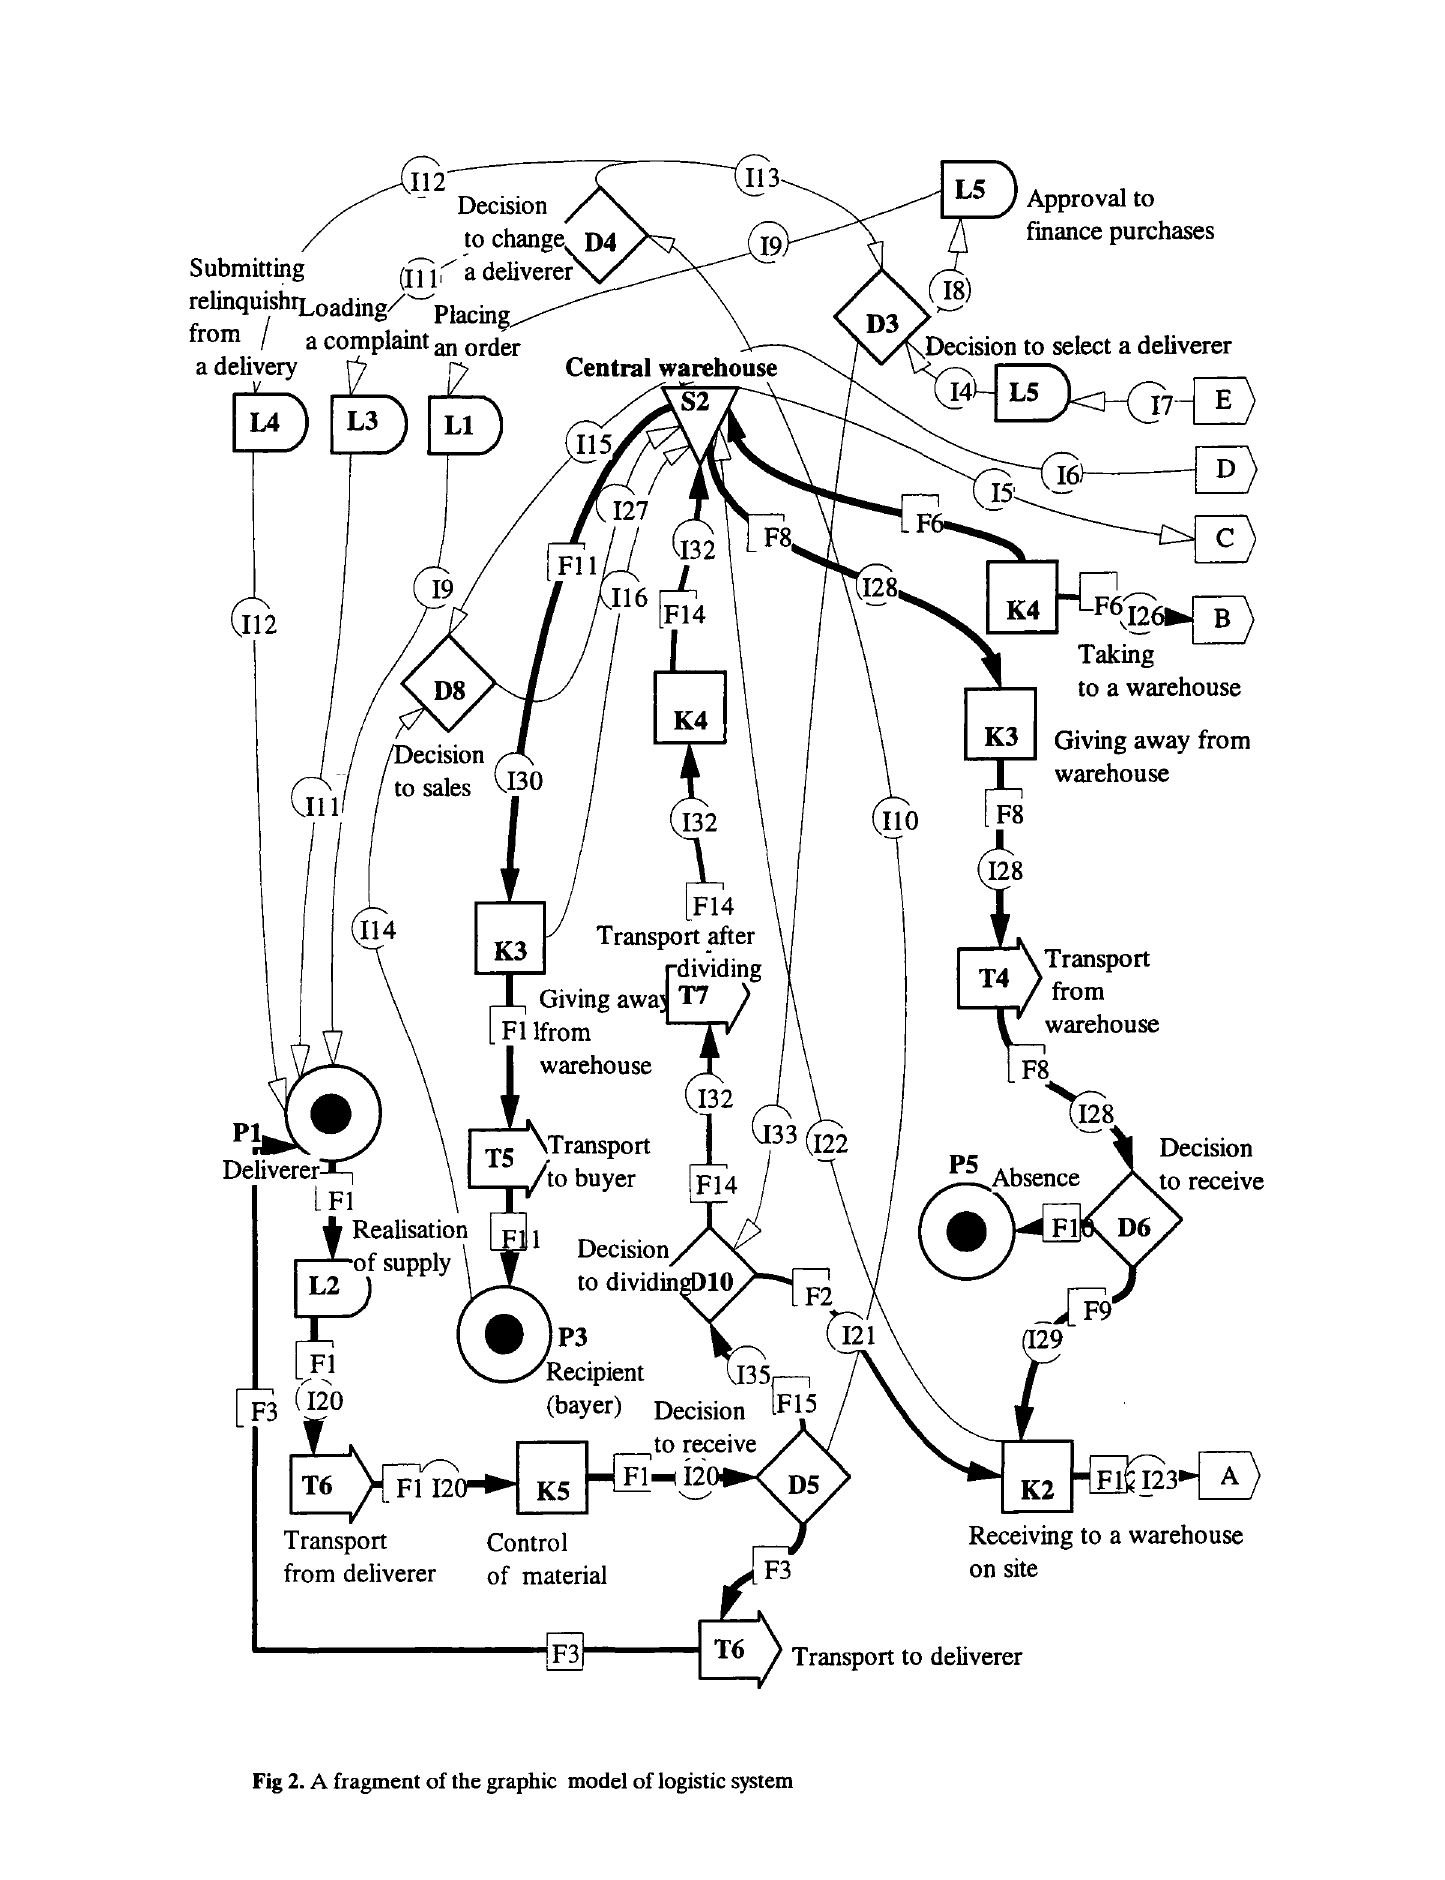
Fig 2. A fragment of the graphic model of logistic